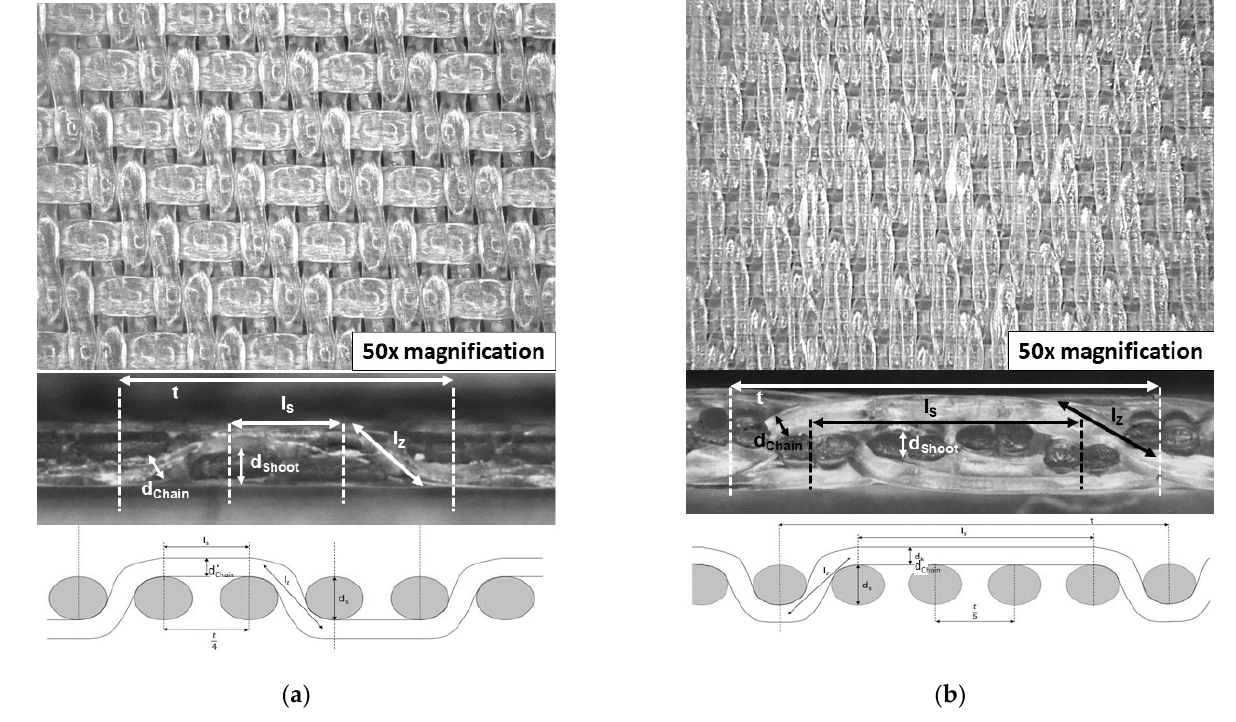
Figure 1. Microscopic image as top and side view and schematic drawing of the filter cloths: ( a ) F1-TWL-80/100; ( b ) F2-STN-20; t = length to the repetition on the chain/shoot thread; d Chain/Shoot = diameter of chain/shoot thread; l S = length straight-thread section; l Z = length slanted-thread section.